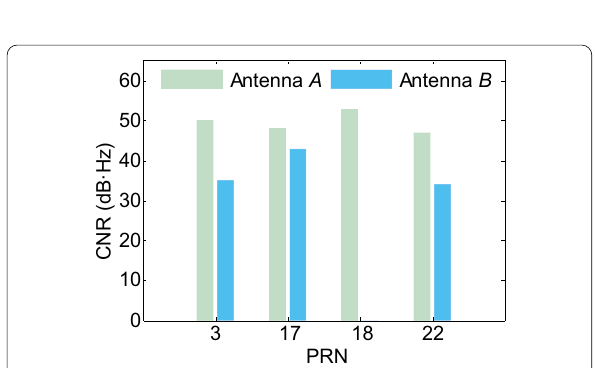
Fig. 9 CNR of the satellite from antenna A and antenna B